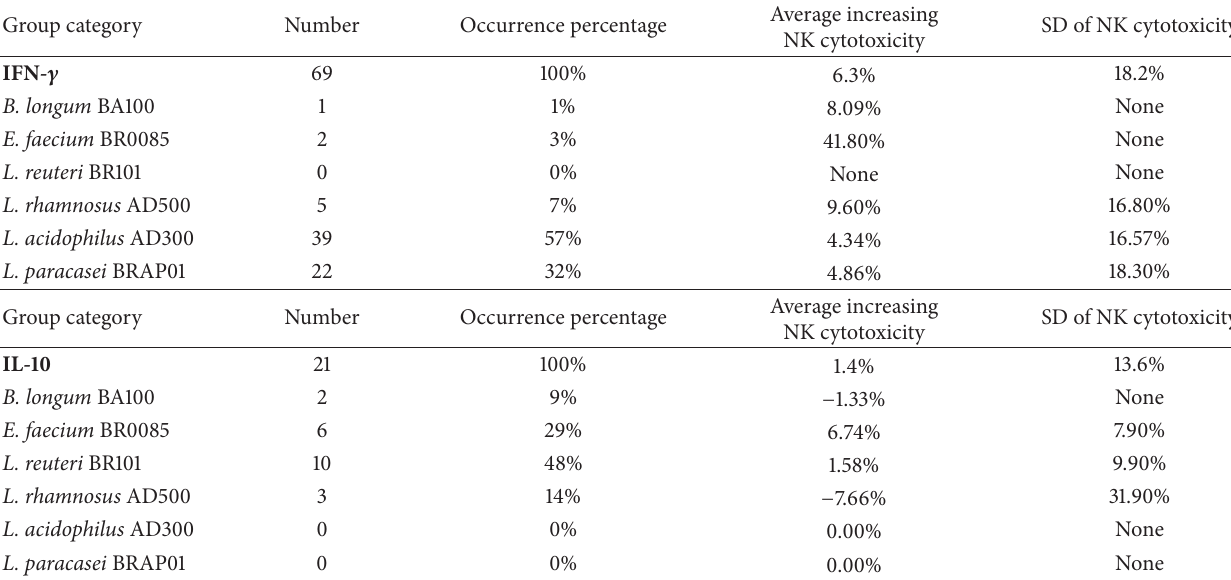
Table 3: Profiles of probiotics after microfluidic assays and the corresponding NK activity change for each probiotic after six months. Group